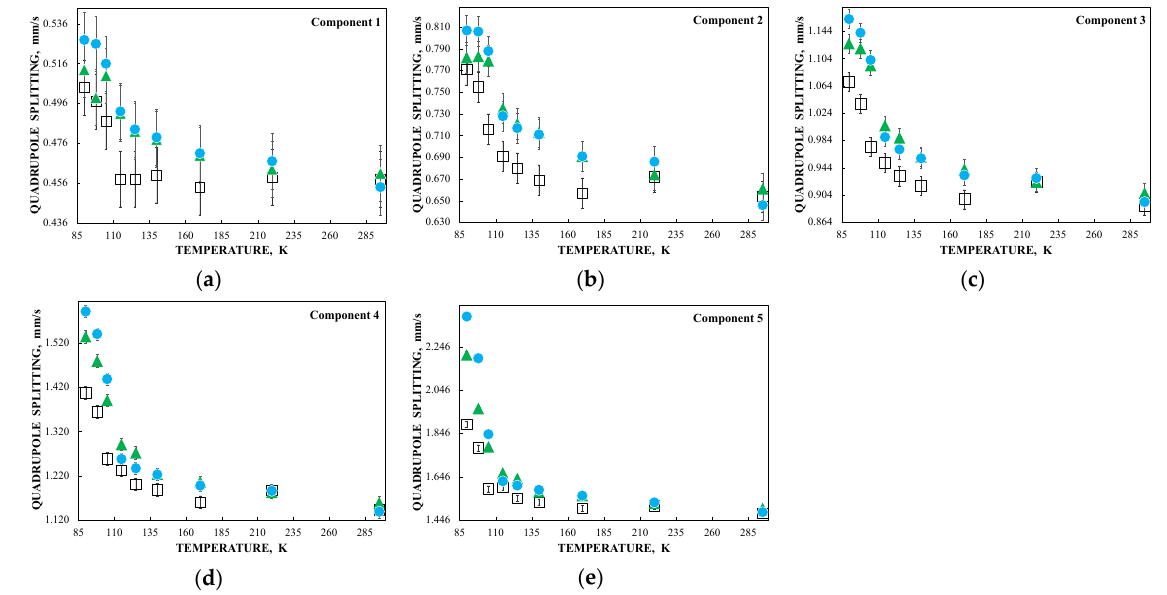
Figure 26. Unusual temperature dependencies of isomer shift for spectral components 1 ( a ), 2 ( b ), 3 ( c ), 4 ( d ) and 5 ( e ) obtained within the new heterogeneous iron core model used for fitting the Mössbauer spectra of Ferrum Lek ( □ ), Maltofer ® ( ▲ ) and Ferrifol ( • ). Adapted from Ref. [50] with permission from Springer Nature: Hyperfine Interactions, “Unusual temperature dependencies of Mössbauer parameters of the nanosized iron cores in ferritin and its pharmaceutical analogues”, Nanomaterials 2022 , 12 , x FOR PEER REVIEW Alenkina I.V., Kuzmann E., Felner I., Kis V.K., Oshtrakh M.I., ©2021.